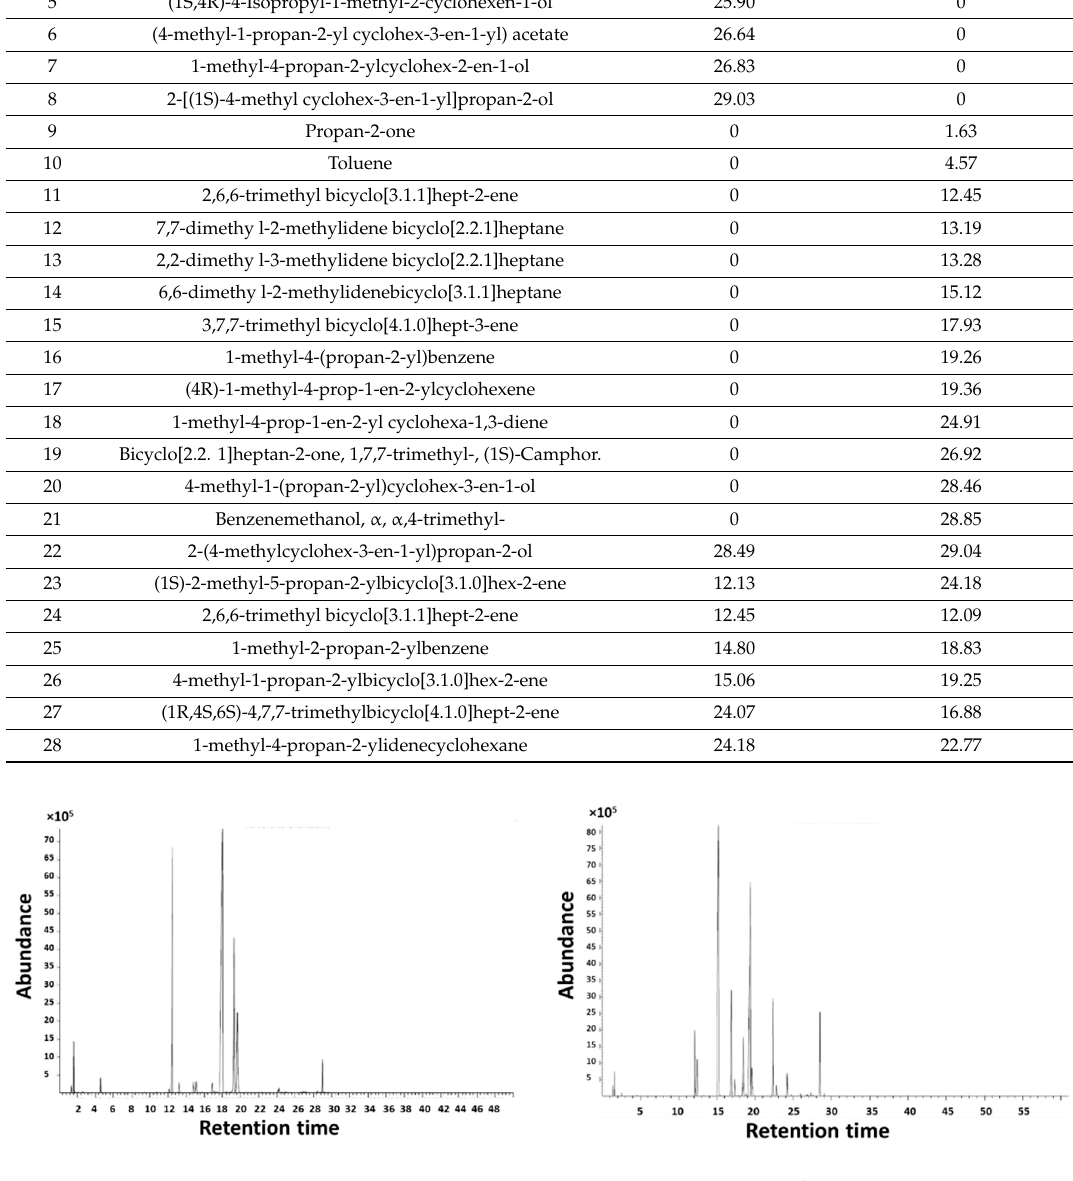
Figure 3. Total ion current (TIC) chromatogram of: ( a ) okoume and ( b ) aiele essential oils.